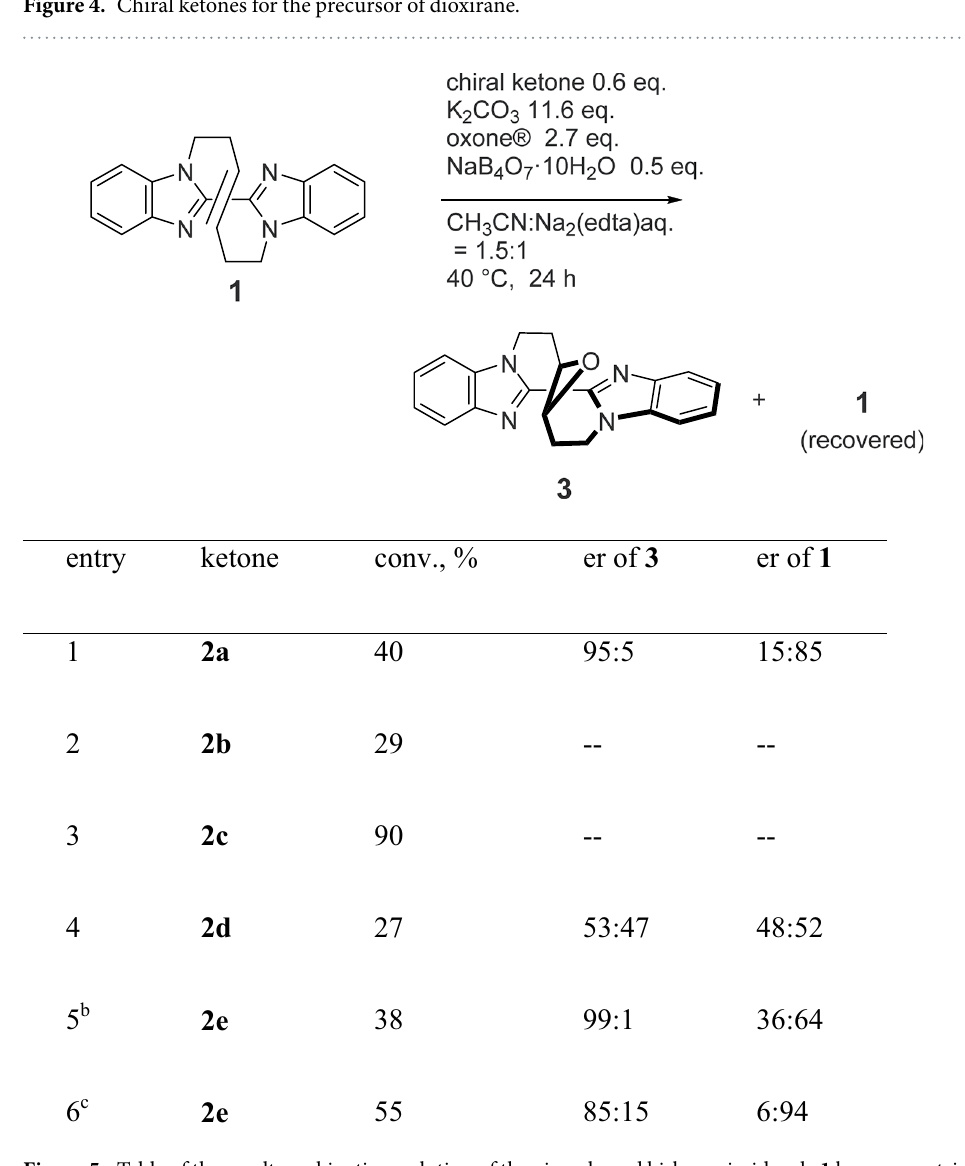
Figure 5. Table of the results on kinetic resolution of the vine-shaped bisbenzoimidazole 1 by asymmetric epoxidation with several chiral ketones a . a Unless noted, the reaction was carried out with 0.6 eq of chiral ketone, oxone ® (2.7 eq), and K 2 CO 3 (11.6 eq) in CH 3 CN/aq. b The reaction was carried out at 60 °C for 24 h. c The reaction period: 48